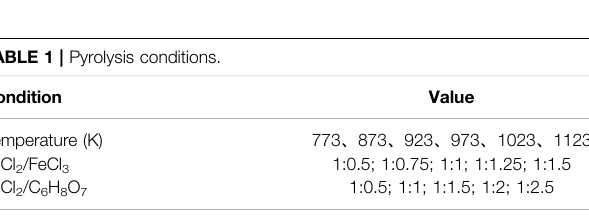
TABLE 1 | Pyrolysis